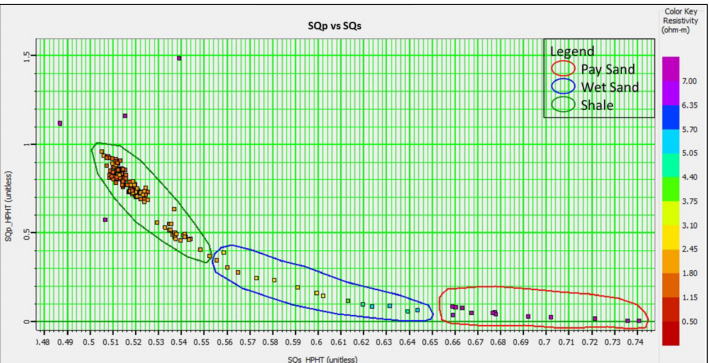
Figure 11. SQp vs. SQs cross plot with colour-coding based on resistivity for pay sand delineation.